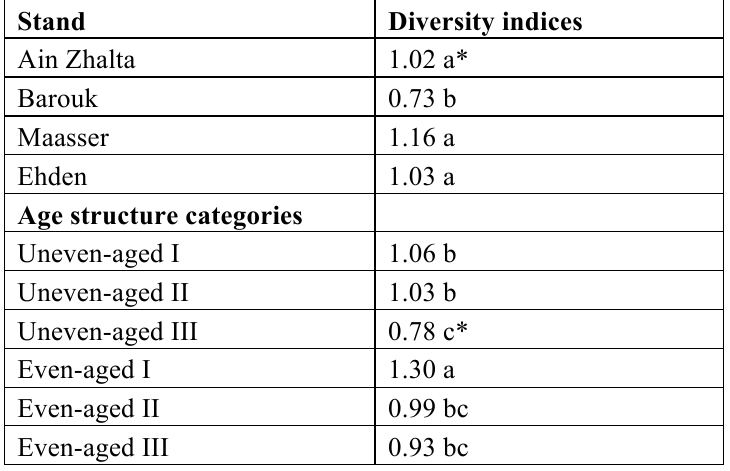
Table 3. Mean Shannon diversity indices in the four stands and in different categories of age